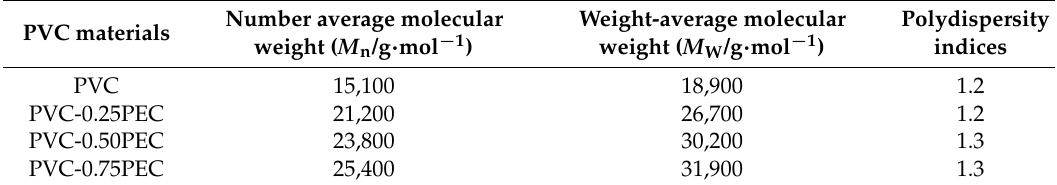
Table 1. Relative molecular mass and polydispersity indices of PVC materials.